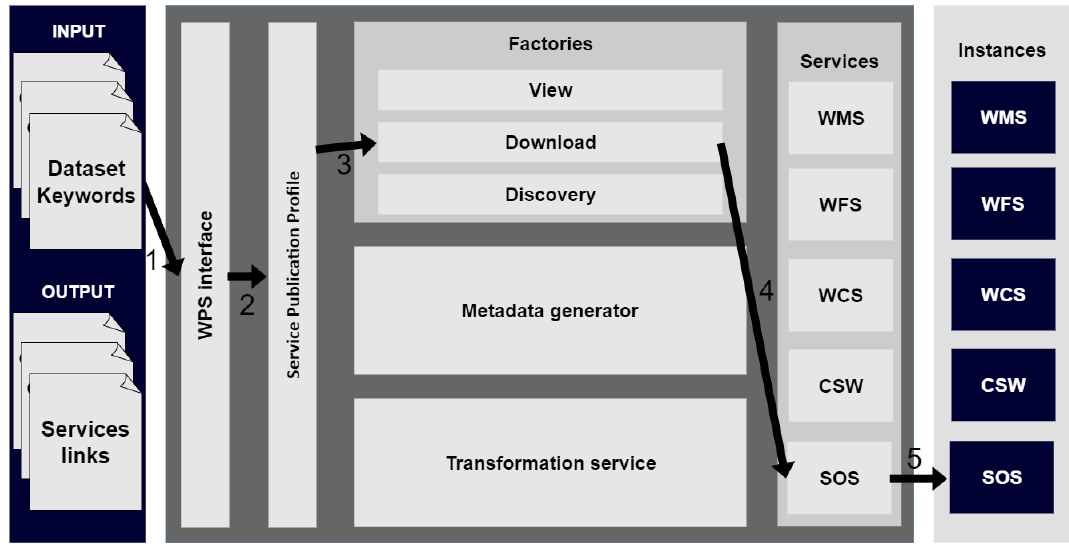
Figure 6. Different steps for the publication of sensor data using